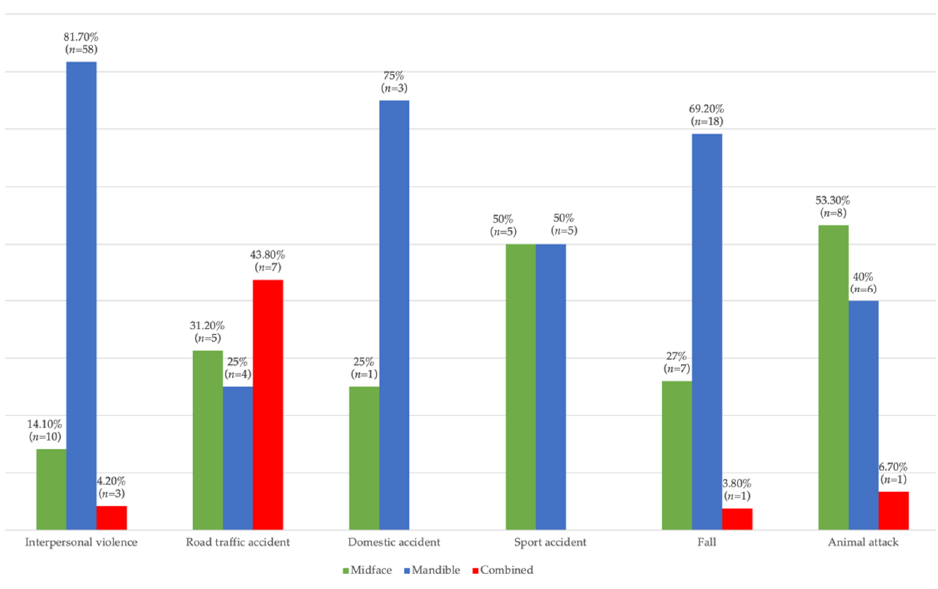
Figure 5. Distribution according to line of fracture and etiology.